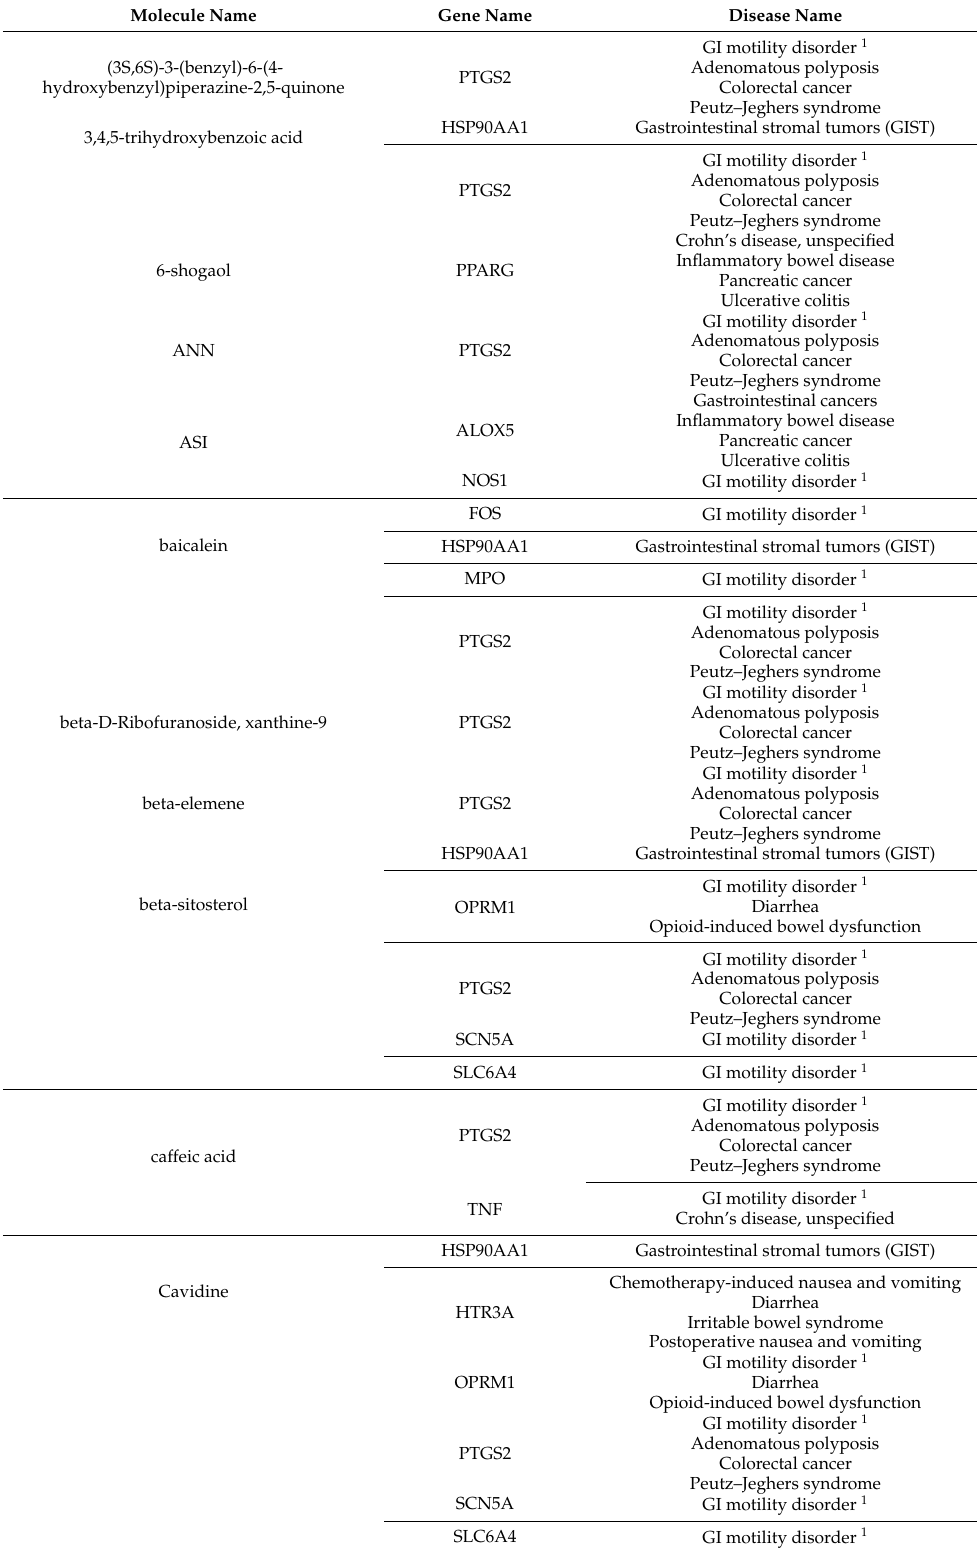
Table 2. Compounds and targets related to gastrointestinal (GI)